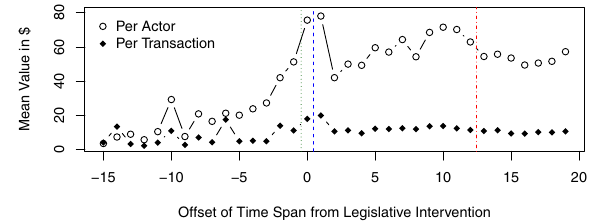
Fig. 5 Mean transaction values. Temporal representation of the mean transaction value per actor (circles) and the mean of each transaction value (diamonds) for 30-day spans. The mean value of dollars exchange per actor in any given 30-day span is around $58.6 after tax-incentives (span 0) with $11.3 as the mean for each